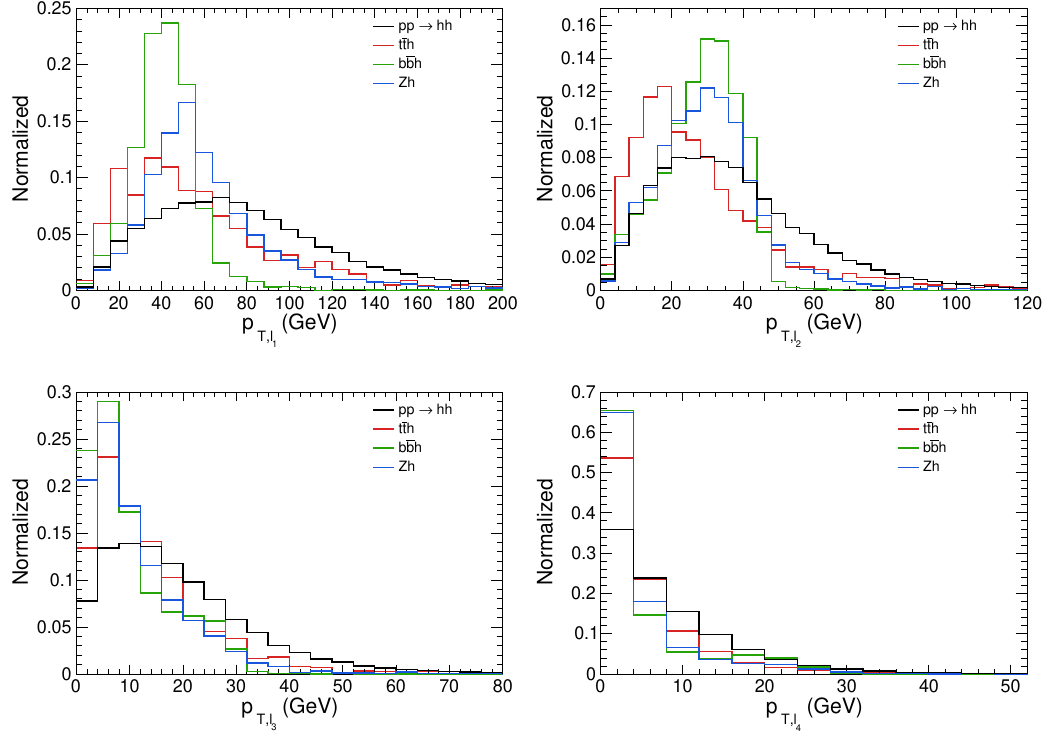
Figure 9 . Normalized distribution of the transverse momentum, p T , of the four leptons produced via: pp → hh → b ¯ bZZ ∗ → b ¯ b ( ZZ ∗ → 4 l ) , at the parton